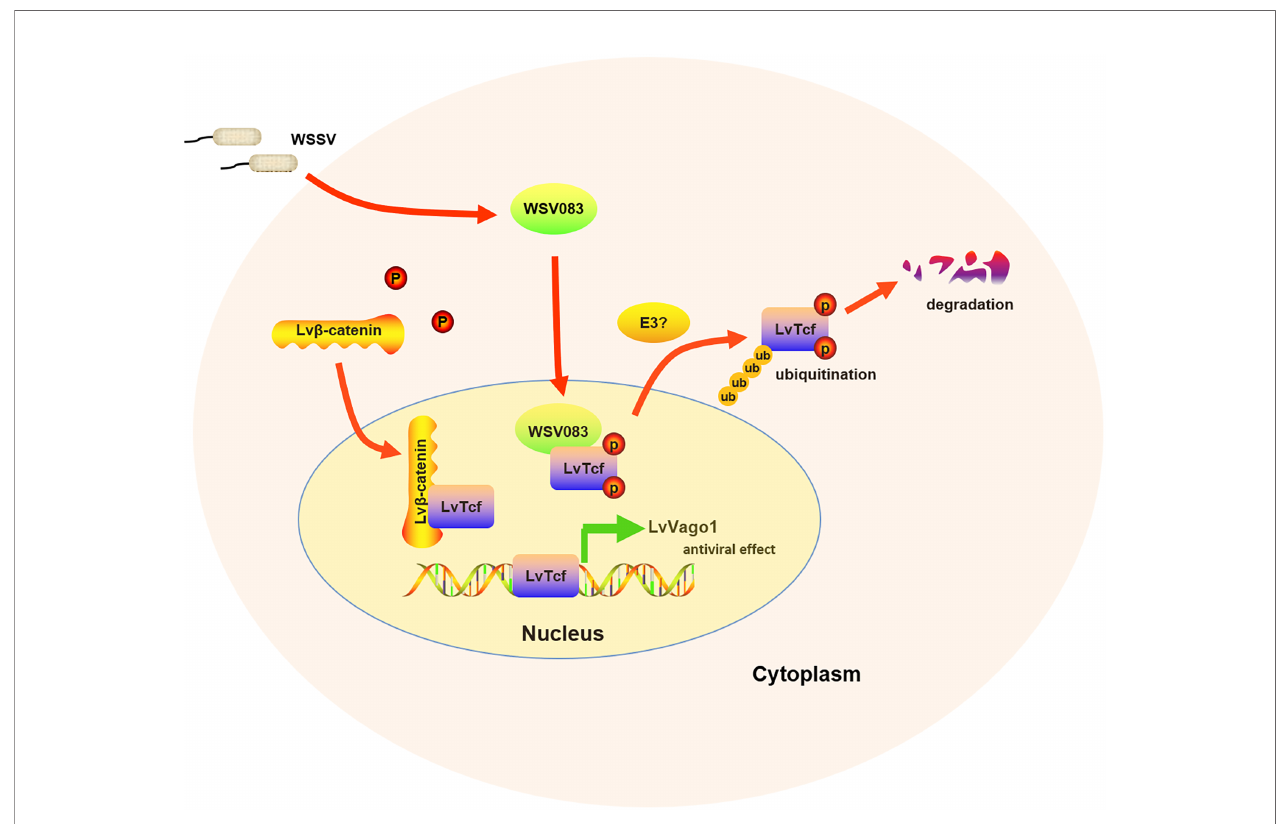
FIGURE 7 | Model of the relationship between LvTcf and WSSV infection. WSSV infection (pathogenic stress) induced the LvTcf-driven production of interferon-like protein LvVago1 independently of Lv b -catenin, as an antiviral defense mechanism. However, WSSV encodes a serine/threonine protein kinase, WSV083, which phosphorylates LvTcf. Phosphorylated LvTcf is translocated to the cytoplasm, recognized by an E3 ligase, and degraded via the ubiquitin-proteasome